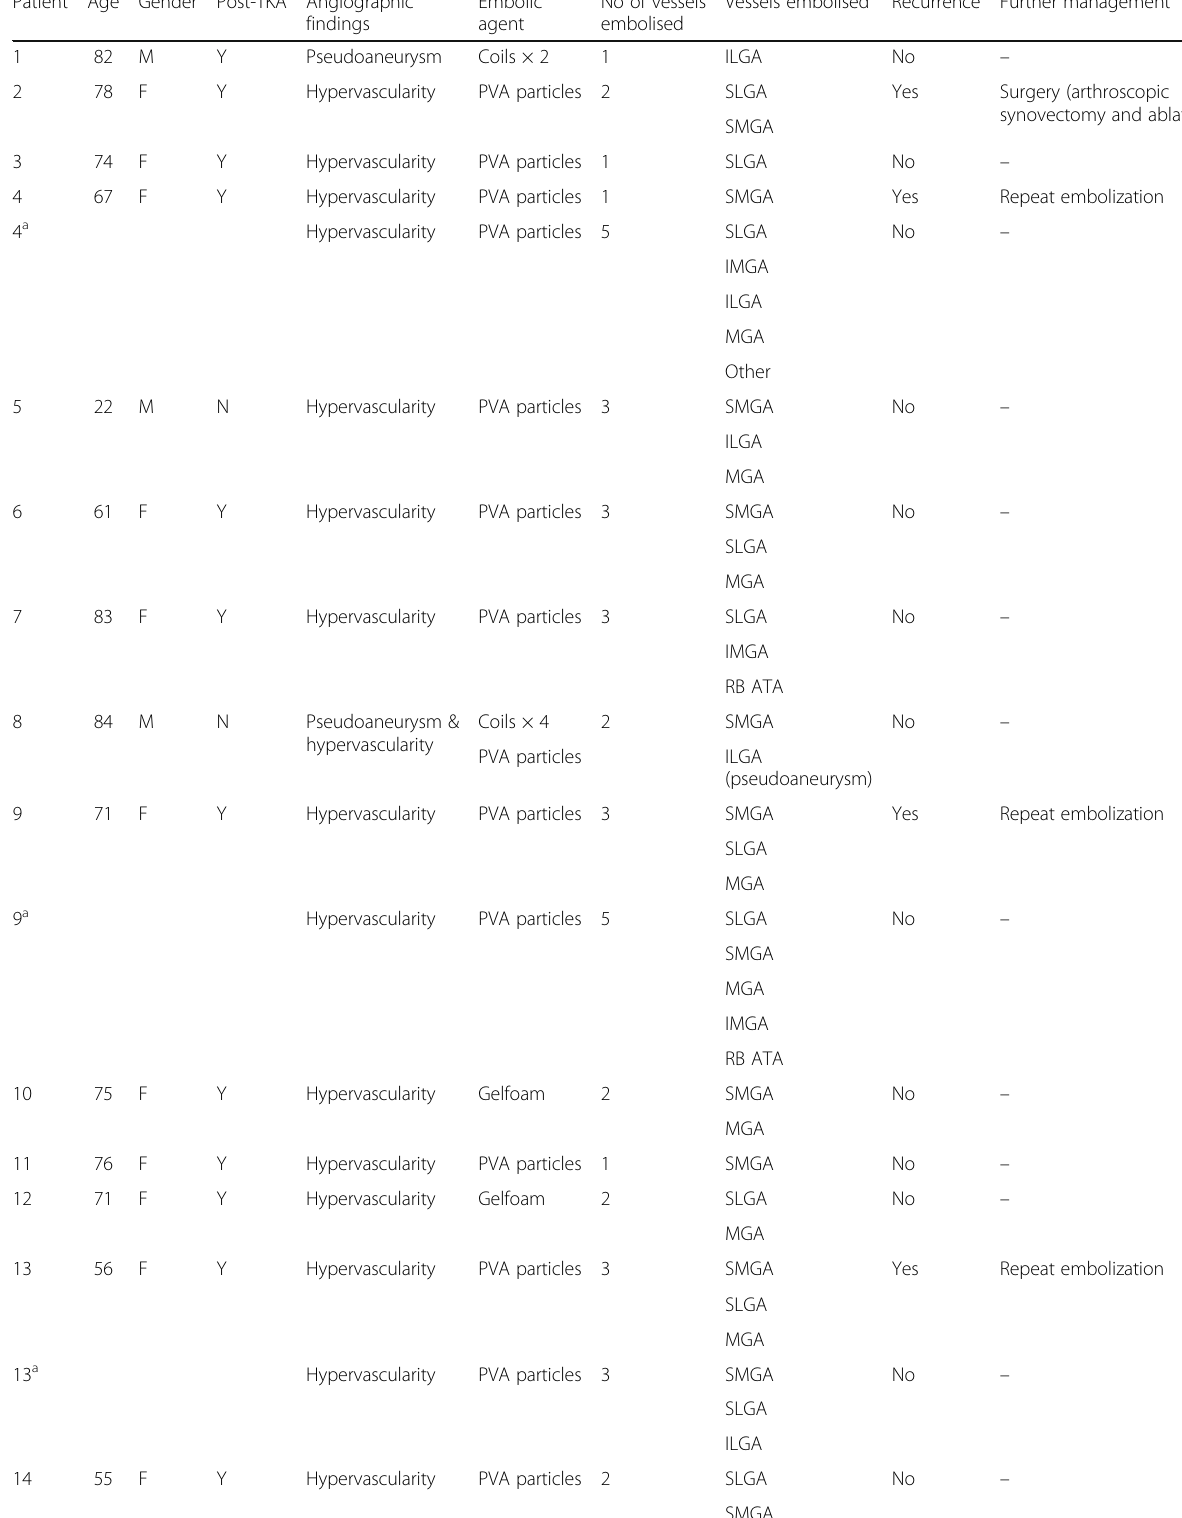
Table 1 Characteristics and procedure details for patients undergoing angiography and embolization for recurrent hemarthrosis of the knee Patient Age Gender Post-TKA Angiographic